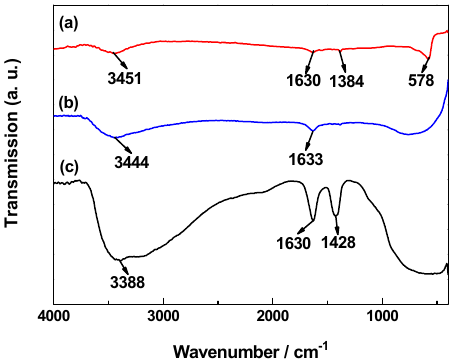
Figure 3. FTIR spectra of (a) Fe 3 O 4 magnetic powder; (b) TiO 2 and (c) Fe 3 O 4 /TiO 2 nanocomposite.